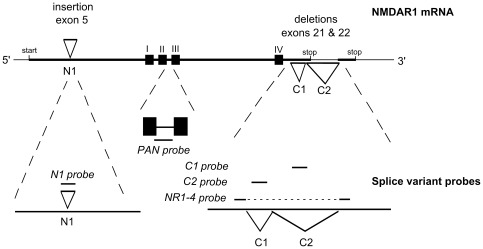
Schematic diagram of NR1 mRNA structure showing positions of the oligonucleotide probes.Note the position of three alternatively spliced exons in the mRNA (upper) and the complementary positions of the splice-specific probes and of a probe identifying a conserved region (lower). Of the mRNA, note the position of the coding areas for the transmembrane domains I to IV (filled squares); the 5′ insertion of exon 5, also known as N1; the 3′ deletions of exon 21 and 22, also known as C1 and C2, respectively; and the start codon and the two alternative stop codons. The positions of the oligonucleotide probes are represented by the short solid lines against a magnified region of the mRNA. Dotted lines reveal the area of the mRNA that has been magnified. Adapted from Laurie and Seeburg [25].